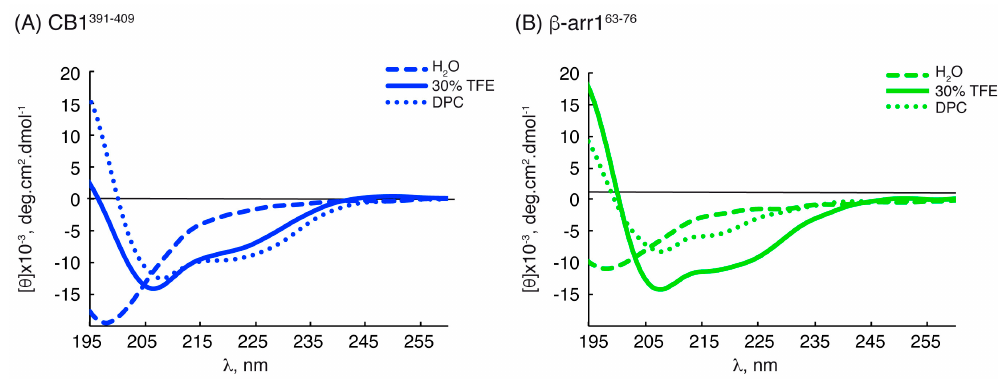
Figure 2. CD spectra of CB1 391-409 ( A ) and β -arr1 63-76 ( B ) in H 2 O (dashed line), TFE (continuous line) and DPC (dotted line) (30 mM). Data were collected at 5 °C, pH 5.5 and 50 µM peptide concentration. Table 1. Percentages of helical populations for CB1 391-409 and β -arr1 63-76 peptides from CD and NMR data (see Materials & Methods) in H 2 O, TFE and DPC at 25 °C.